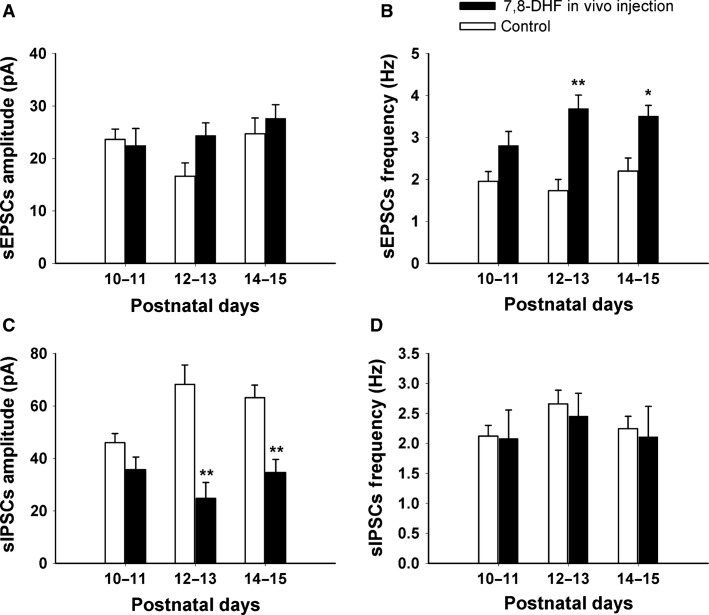
Amplitude and frequency of sEPSCs and sIPSCs in NTSVL neurons after in vivo application of 7,8-DHF. (A) The amplitude of sEPSCs was increased by 7,8-DHF during the critical period, although it did not reach statistical significance. Changes in the amplitude before (P10–11) and after (P14–15) the critical period were also not significant. (B) The frequency of sEPSCs increased significantly with 7,8-DHF during (P12–13, P < 0.01) and after (P14–15, P < 0.05) the critical period as compared to respective controls. However, the frequency of sEPSC at P10–11 was not affected by the drug. (C) The amplitude of sIPSCs decreased significantly with 7,8-DHF at P12–13 (P < 0.01) and P14–15 (P < 0.01). However, the amplitude was not affected by 7,8-DHF at P10–11. (D) The frequency of sIPSCs recorded at different postnatal days (P10–11, P12–13, and P14–15) after 7,8-DHF was not significantly different from that of controls. Data are presented as mean ± SEM, *P < 0.05, **P < 0.01 (significance between control and 7,8-DHF-treated groups).